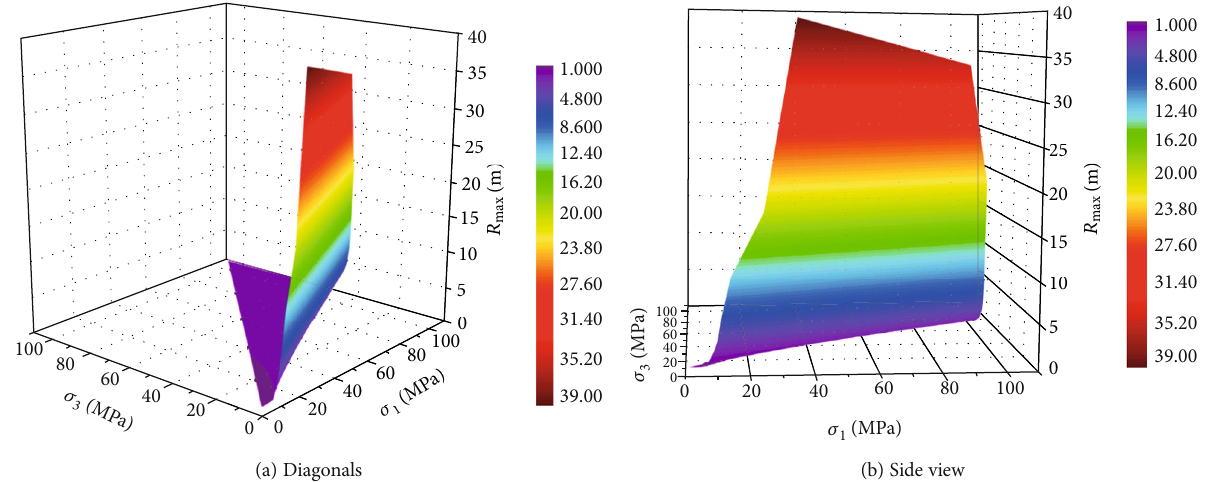
Figure 6: Right surface map of the relationship between the plastic zone radius and the principal stress.